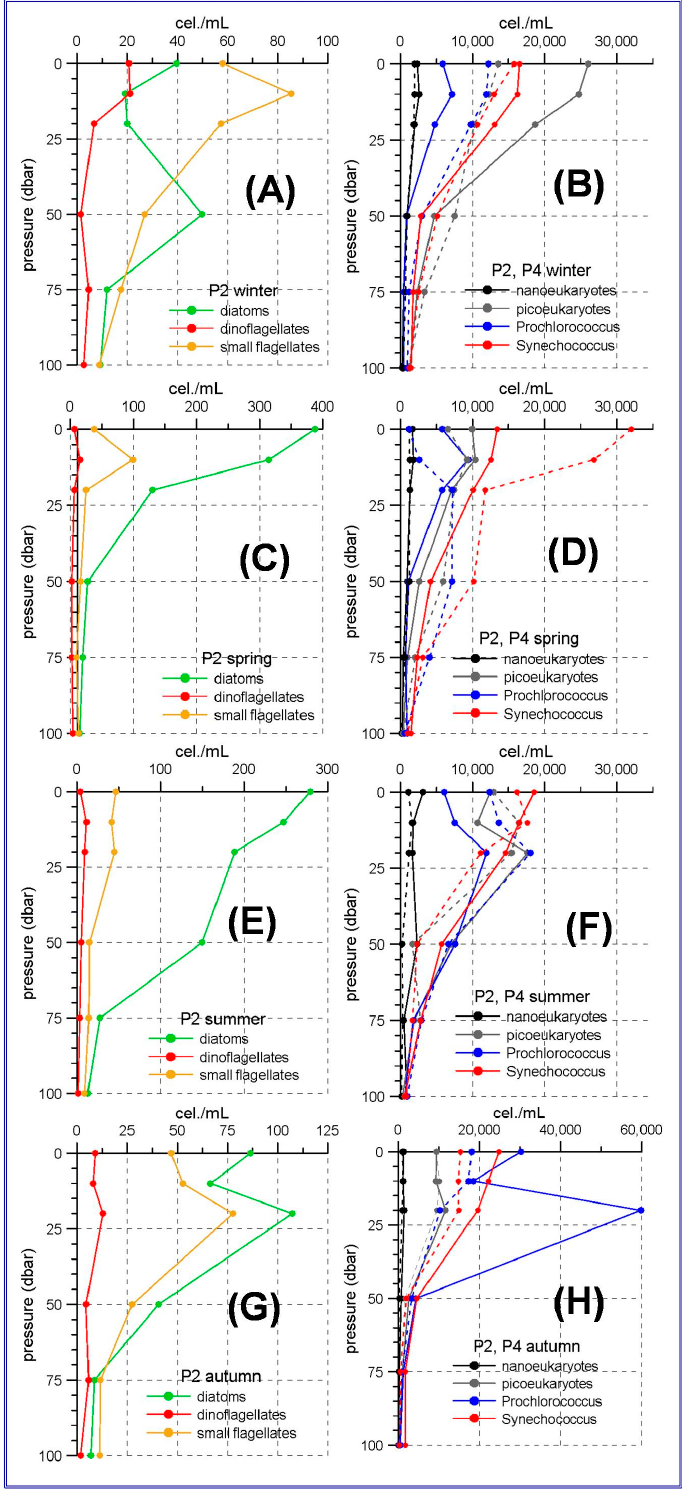
Figure 2. ( A ) shows the winter average vertical distribution of diatom abundances (green line), small flagellates (yellow line) and dinoflagellates (red line) at station P2. ( B ) shows the winter average vertical distribution for nanoeukaryotes (black line), picoeukaryotes (grey line), Prochlorococcus (blue line) and Synechococcus (red line) at the stations P2 (solid line) and P4 (dashed line). ( C , D ) are the same for spring, ( E , F ) for summer and ( G , H ) for autumn.